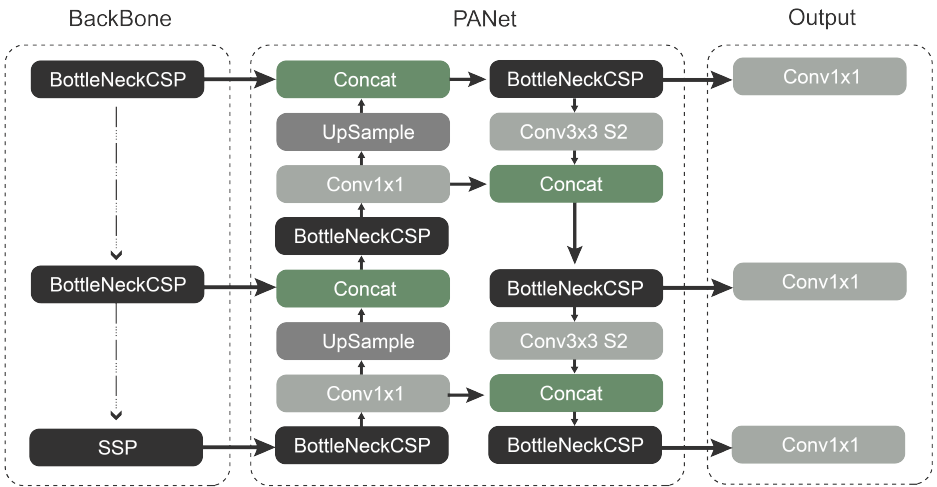
Figure 2. YOLOv5